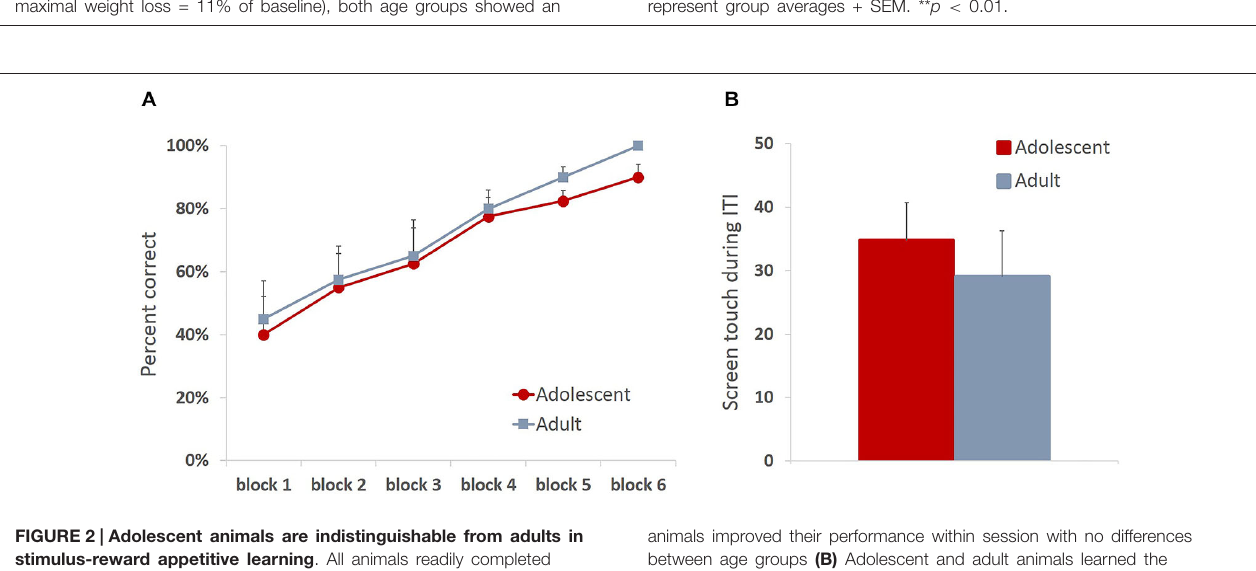
FIGURE 1 | Mild food restriction did not compromise healthy development of the animals . The weights were monitored daily from the beginning of food restriction and until the end of behavioral testing. (A) Although there was an initial weight loss in adult group (average maximal weight loss = 11% of baseline), both age groups showed an